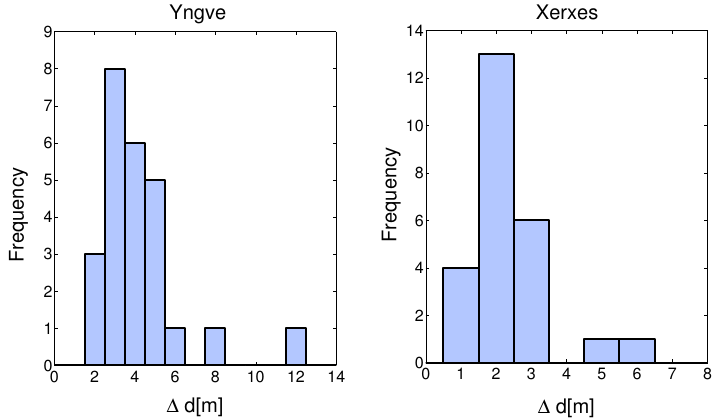
Figure 12. Histograms of the de-correlation distances of all NLOS communication links in the intersections Yngve and